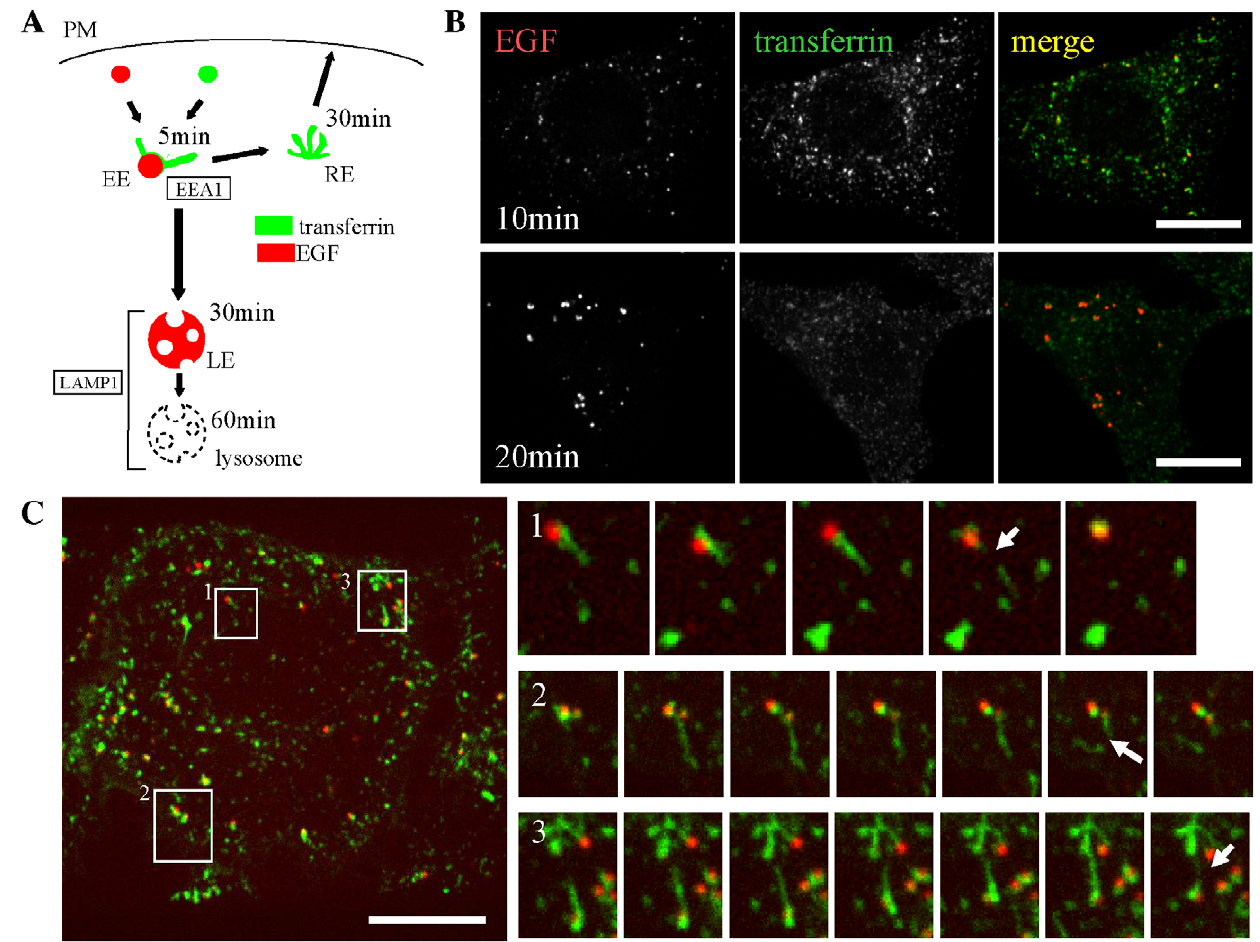
Figure 1. Recycling and degradative pathways are segregated by tubule fission. A , Recycling and degradative pathway are illustrated, with the typical time course of intracellular transferrin and EGF in our experiments shown. Boxed words represent the marker for each compartment. EE, early endosome; LE, late endosome; RE, recycling endosome. B , HeLa cells were bound to Alexa555-EGF and Alexa488-transferrin on ice. After rinsing, the cells were incubated at 37 u C for the time indicated and fixed. Scale bar, 20 m m. C , Cells were bound with ligands and transferred to 37 u C as above. Live images were taken 10 min post-internalization. Frames were captured every 2 sec. Scale bar, 20 m m. (Also see Movie S1 )